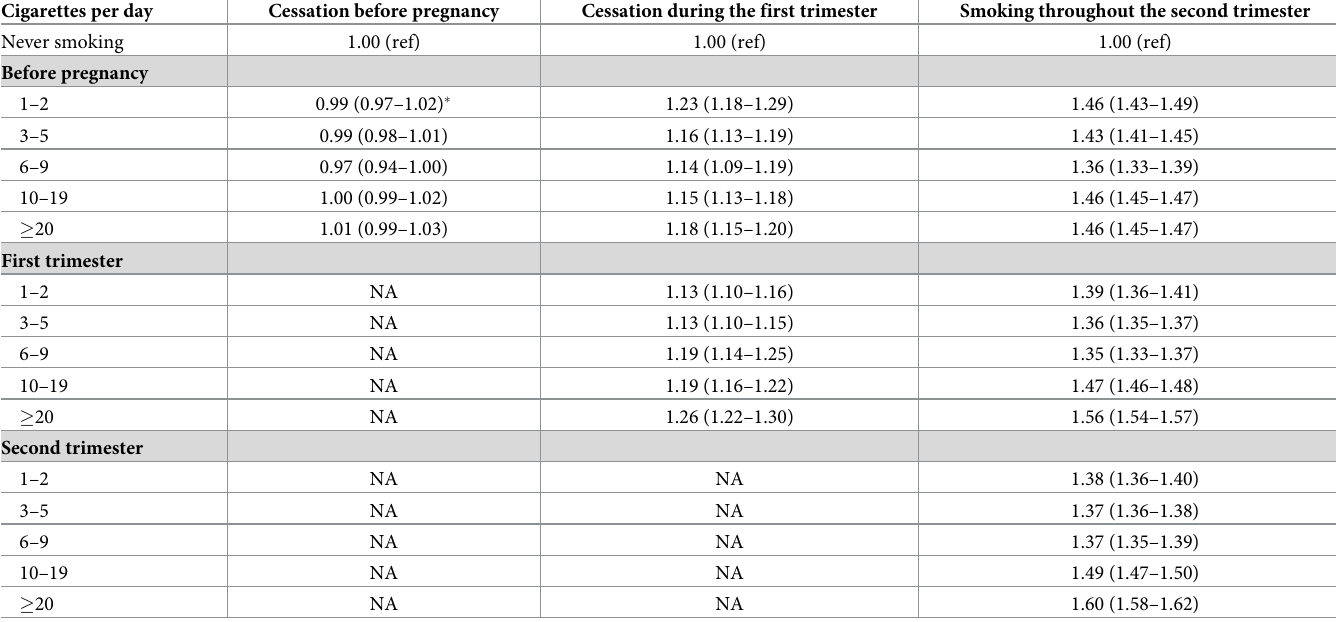
Table 3. Maternal smoking cessation at various periods and risk of preterm